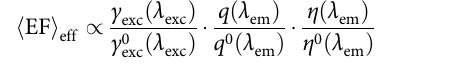
= γ 0 , dependent on the electric fi eld intensity at the exc exc = γ 0 . Inset shows variation of this ratio as a r r = γ 0 r r